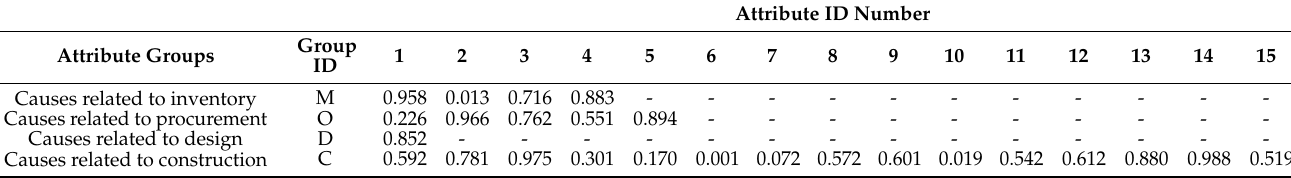
Table 9. Attribute weights after GA